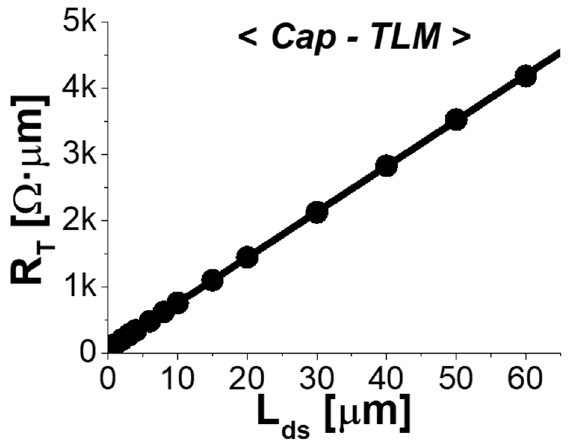
Figure 4. Measured total resistance ( R T ) as a function of L ds for cap-TLM .